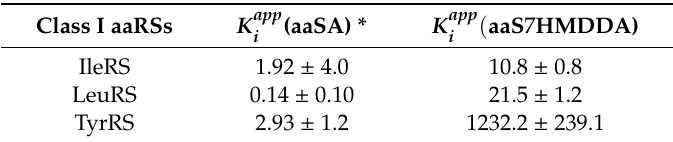
Figure 4. In vitro enzymatic inhibitory activity. ( A ): Inhibitory activity of HMDDA derivatives targeting SerRS and AspRS (class II enzymes) at high concentration. ( B ): Dose-response curves of HMDDA derivatives targeting class I enzymes IleRS, LeuRS and TyrRS. The activity of each enzyme is reported as a percentage value relative to that measured in the absence of inhibitor. The presented fit of the measured points was calculated using the Greco-Hakala equation [24]. Averages of three experiments with SD error bars are shown. Table 1. K app values of the aminoacylated sulfonamide nucleosides for the respective class I enzymes are given in nM.